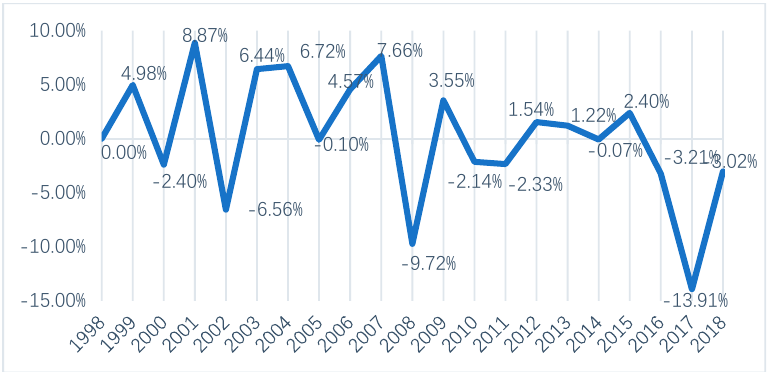
Figure 2. The sequential growth rate of total agricultural carbon emissions in Jilin Province, China.